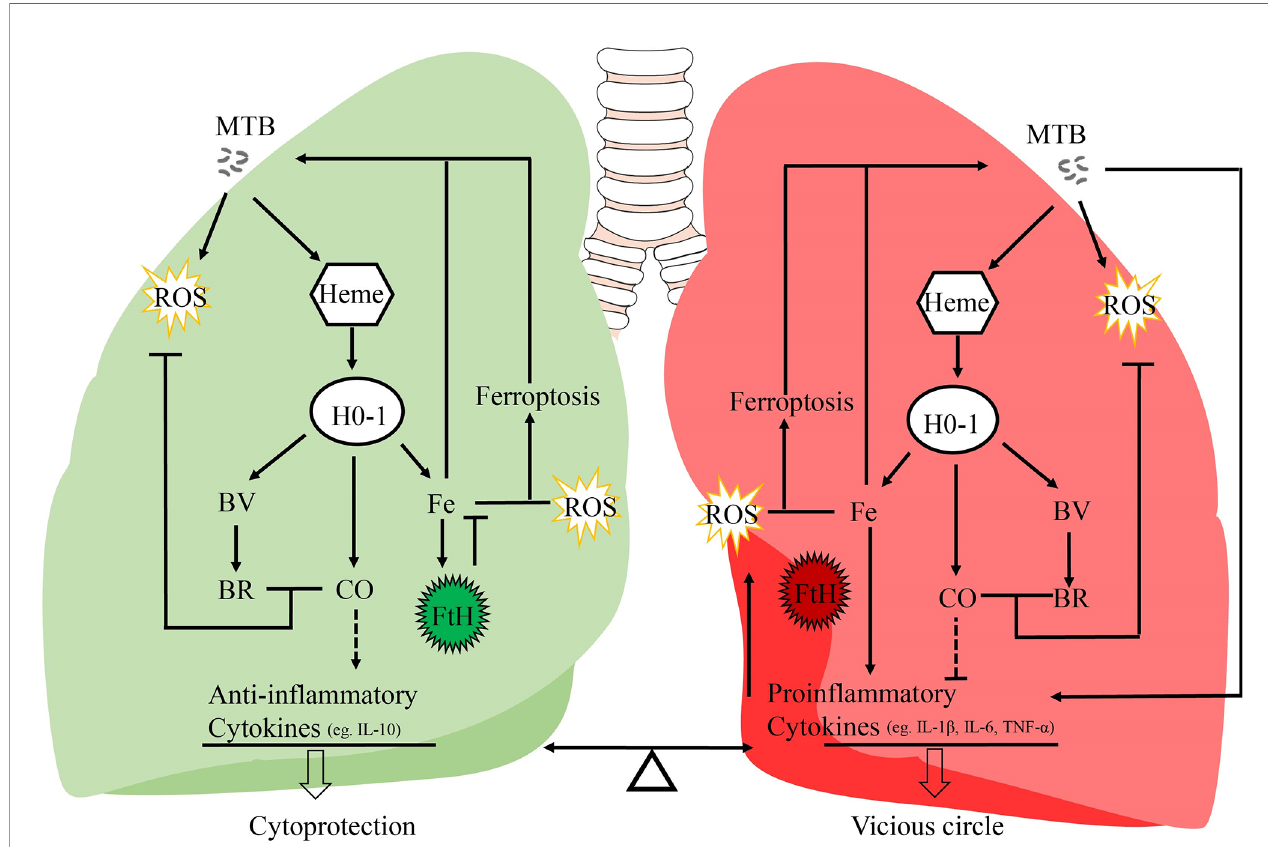
FIGURE 1 | Potential mechanisms of the dual role of HO-1 in TB. It is generally assumed that this HO-1 and its products may act as a crucial regulator in in fl ammatory processes, and regulates the balance between proin fl ammatory and anti-in fl ammatory mediators. IL-10 is responsible for its anti-in fl ammatory properties; IL-1 b , IL-6, and TNF- a are pro-in fl ammatory cytokines secreted by macrophages to initiate and regulate the progression of in fl ammation. MTB, Mycobacterium tuberculosis; HO-1, heme oxygenase-1; ROS, reactive oxygen species; BV, biliverdin; BR, bilirubin; FtH, ferritin heavy chain; CO, carbon monoxide; Fe, free